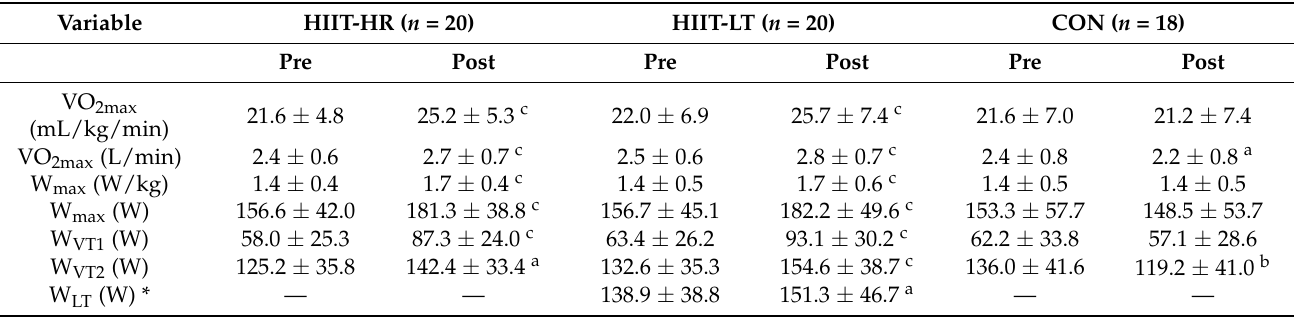
Table 4. Cardiopulmonary exercise testing